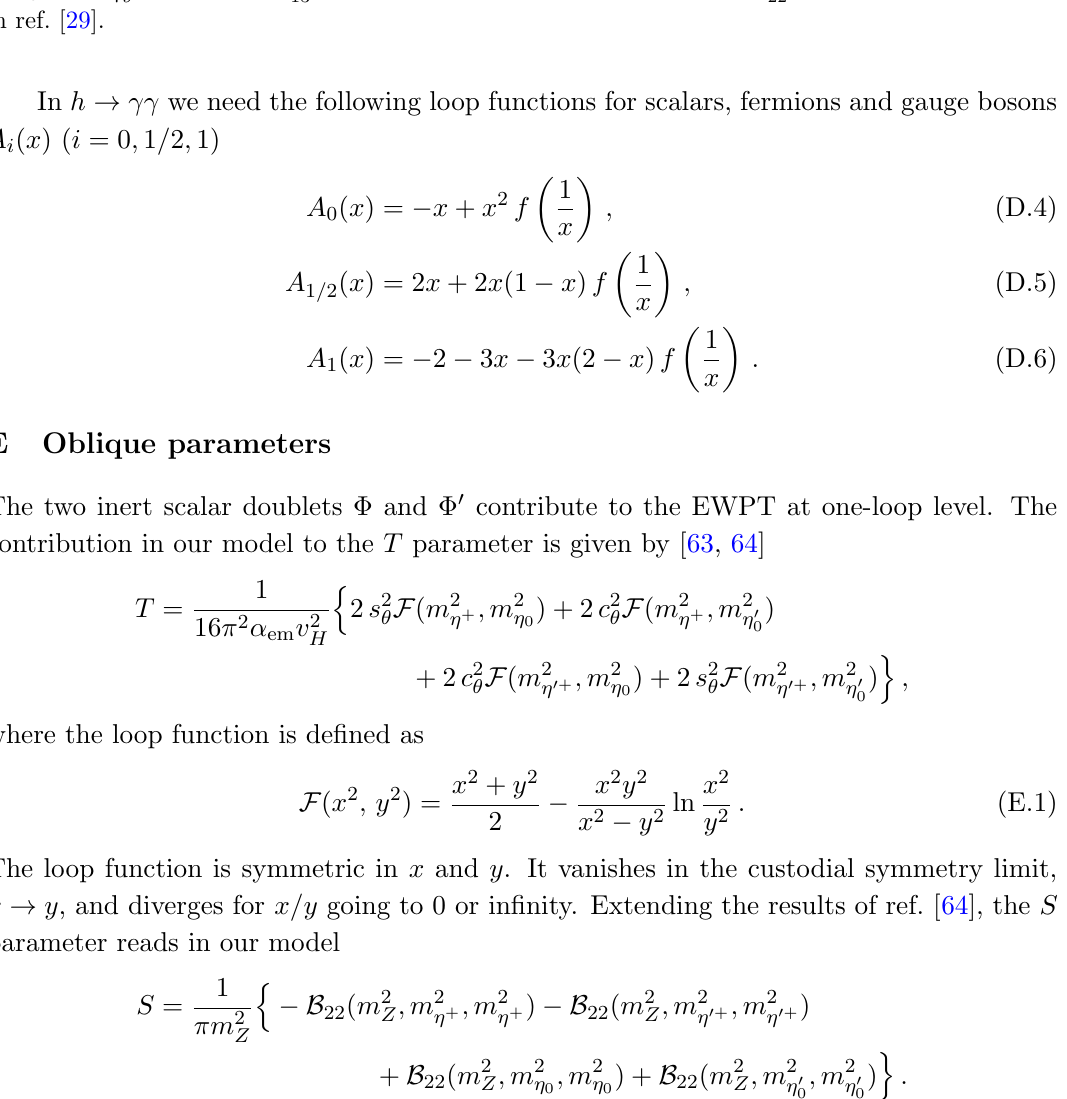
Ti are taken from table 4 22